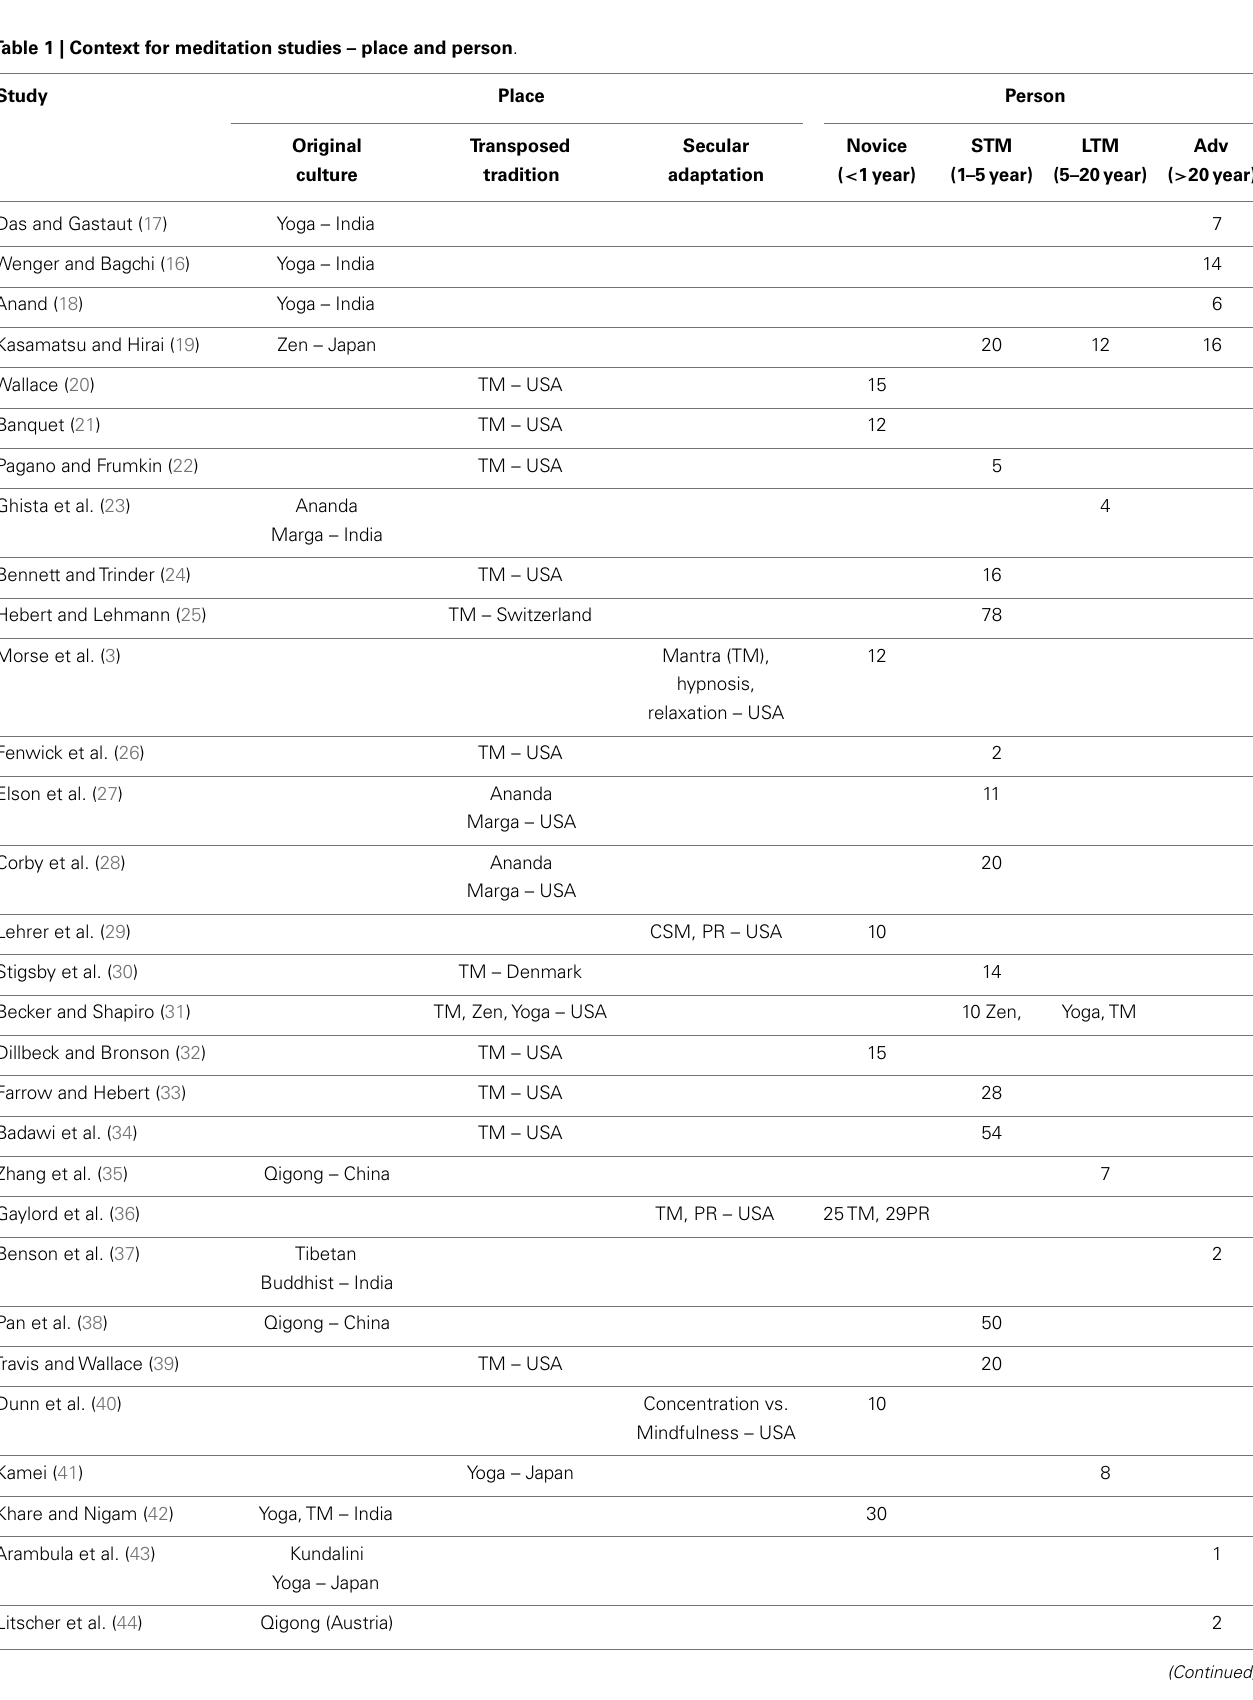
Table 1 | Context for meditation studies – place and person